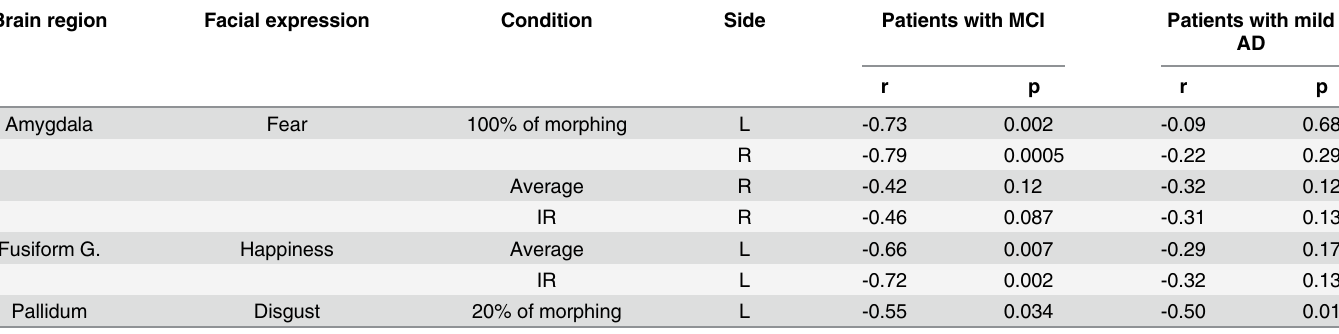
Table 3. Correlations between emotion recognition performance and regional volumes, separated by diagnosis (AD/MCI). Brain region Facial